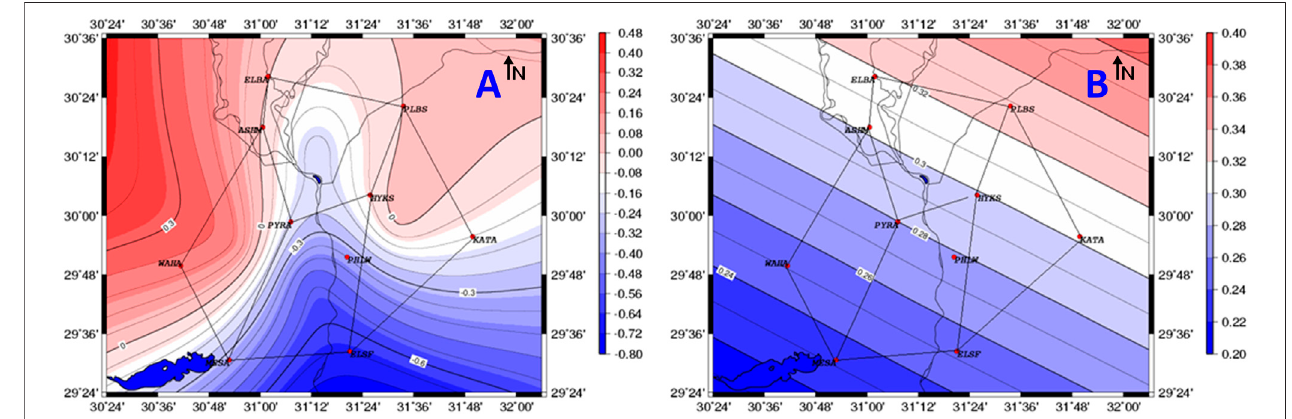
FIGURE 9 | (A) Dilatation rates of the study area from 2005 to 2011. (B) Maximum shear strain rates of the study area from 2005 to 2011.